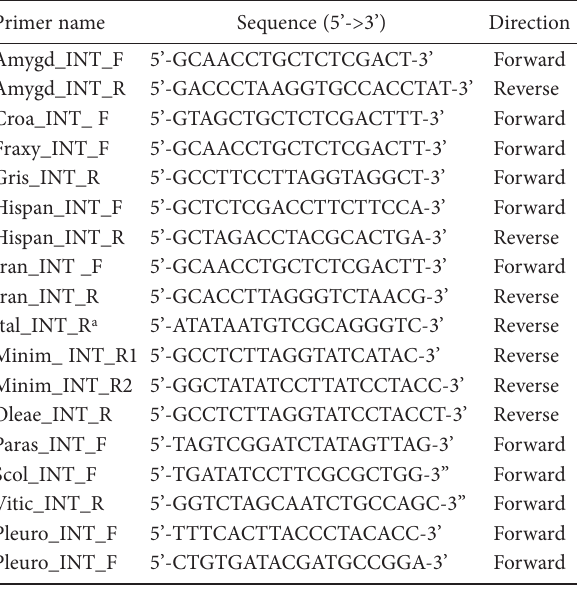
Table 2. Internal sequencing primers designed to obtain the com- plete sequences of the intergenic spacer